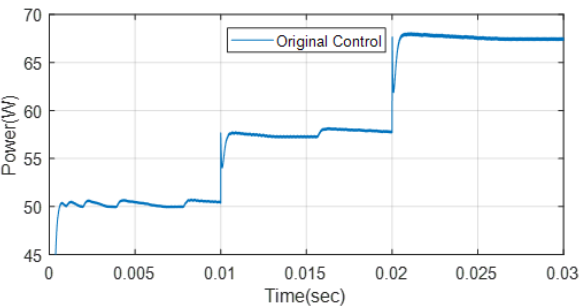
Fig.13: ESU output power for the original controller.